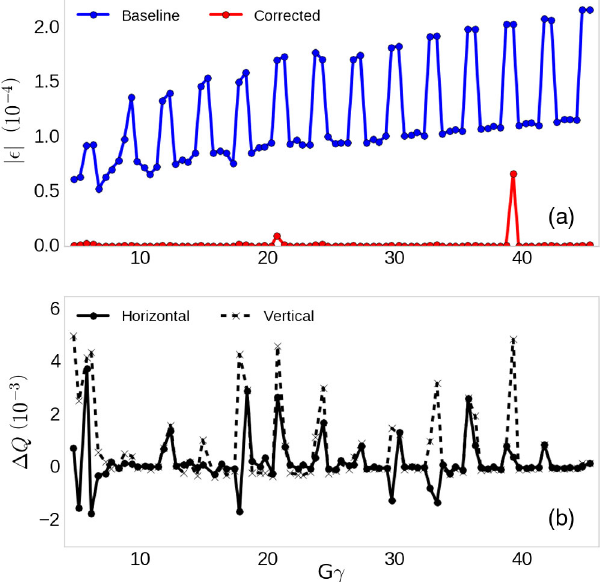
FIG. 3. (a) Horizontal rms resonance strengths before and after implementing the correction and (b) the resulting tune shifts due to betatron coupling (prior to refitting the tunes).